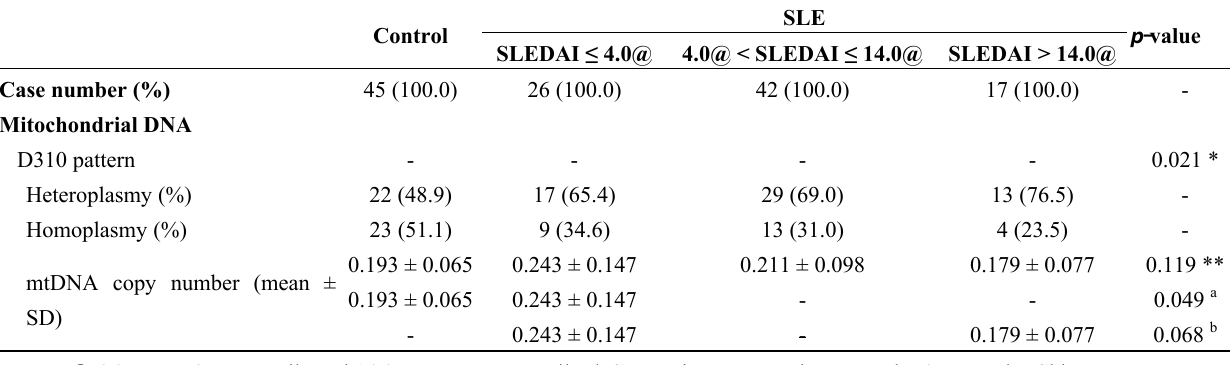
Table 2. Correlation between SLEDAI scores and mtDNA alterations in SLE